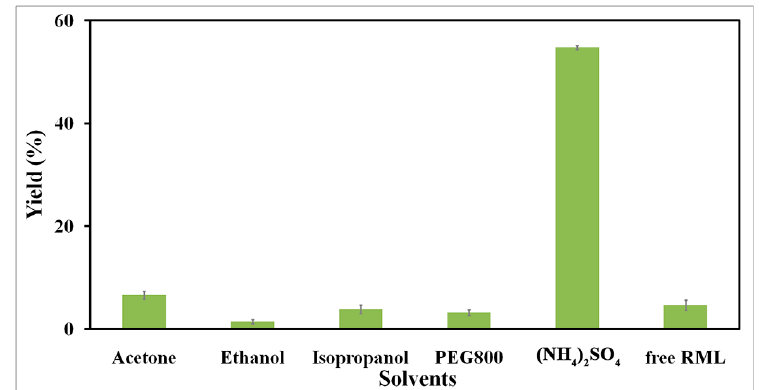
Figure 6. Effect of precipitant type on the activities of magnetic RML CLEAs.